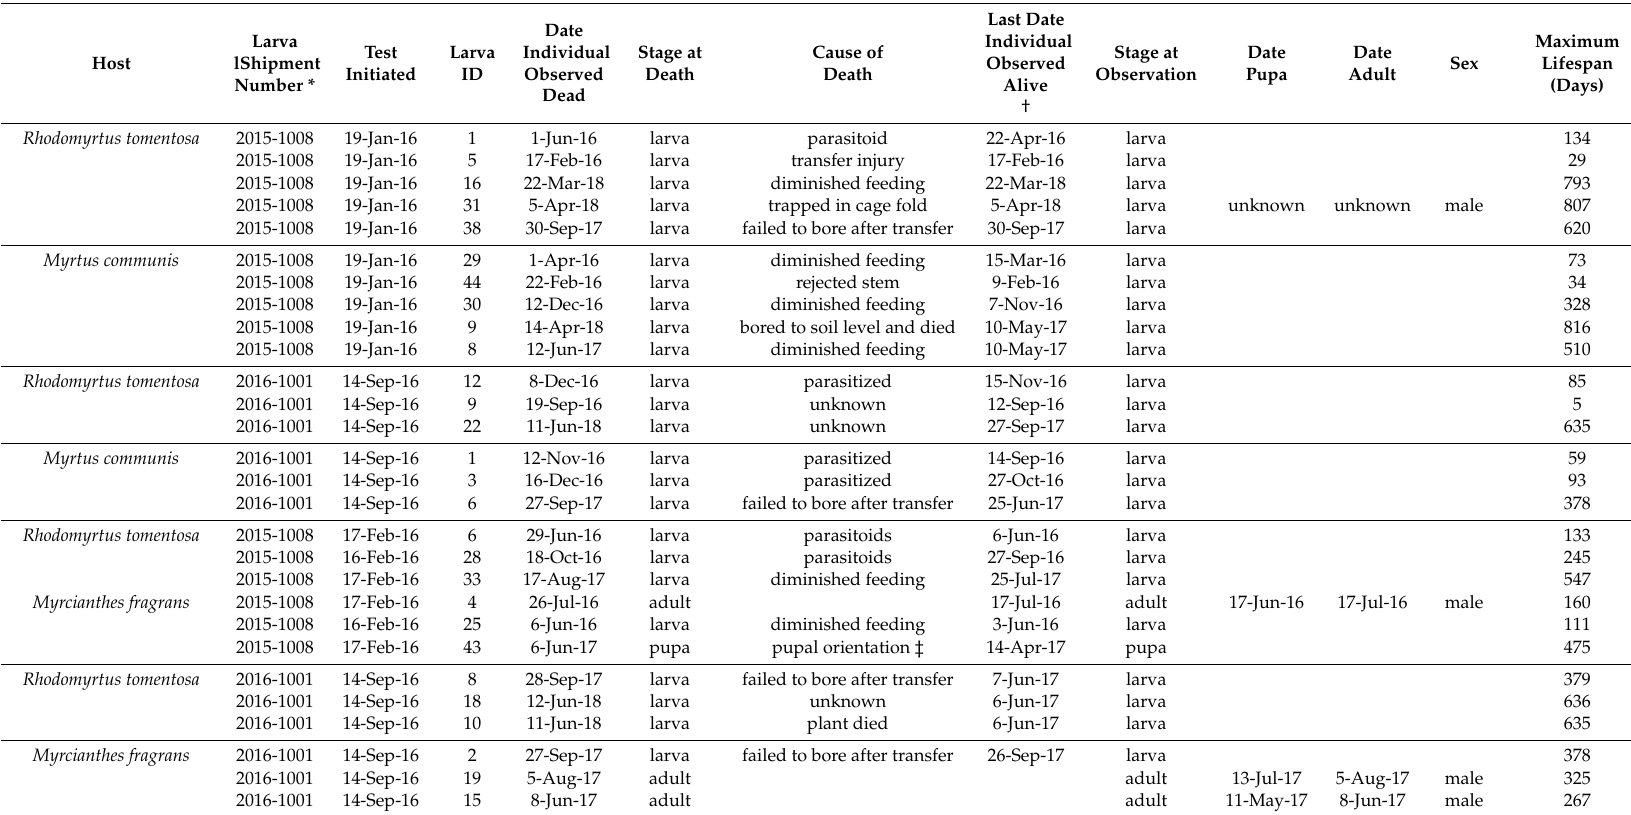
Table 1. No-choice host range test of C. subagronoma on Myrcianthes fragrans and Myrtus communis . Larvae were transferred to cut stems of non-targets and their feeding activity was tracked until death or